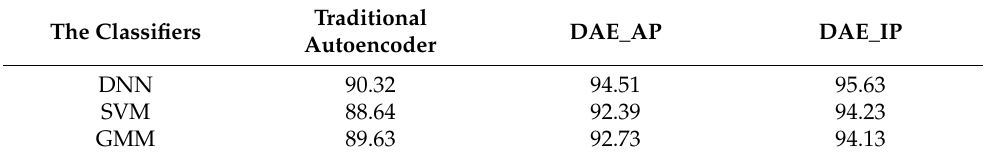
Table 5. The detailed recognition rates (%) for stimuli with different flicking frequencies